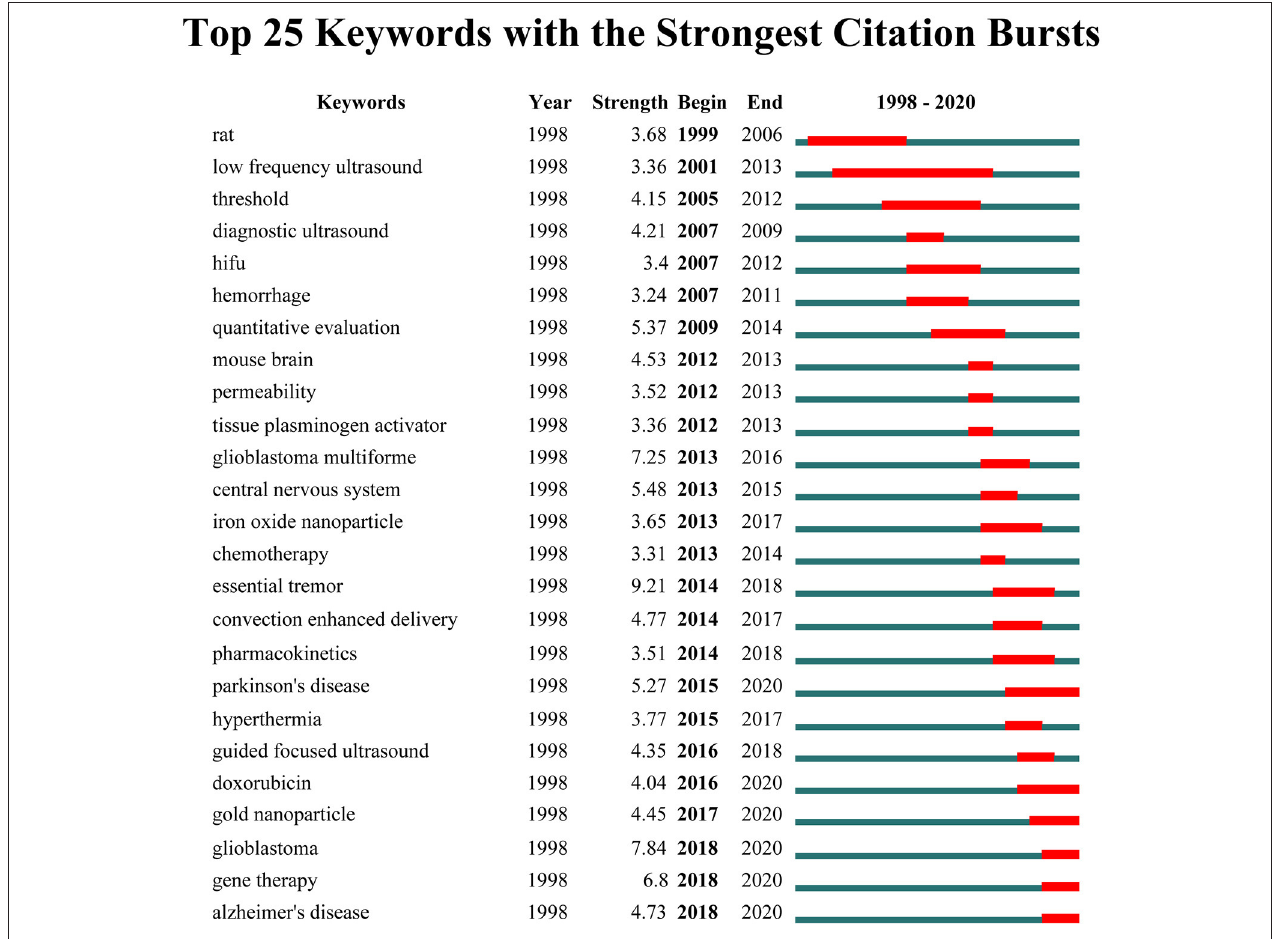
FIGURE 10 | The top 25 keywords with the strongest citation bursts from 1998 to